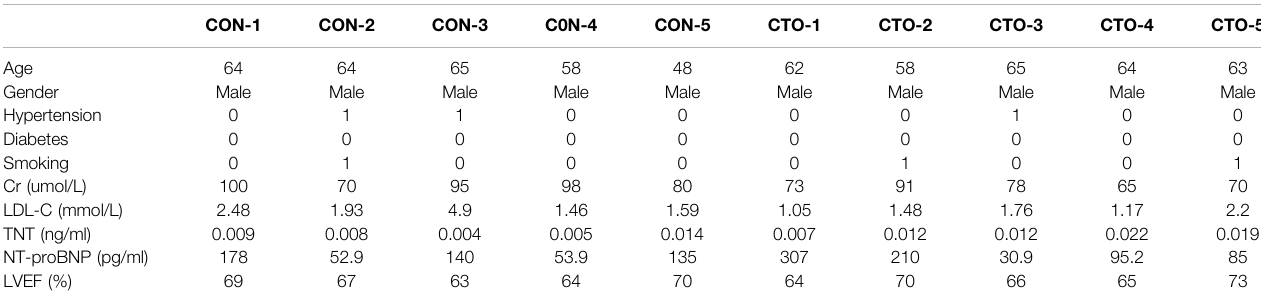
TABLE 1 | Baseline characteristics of included